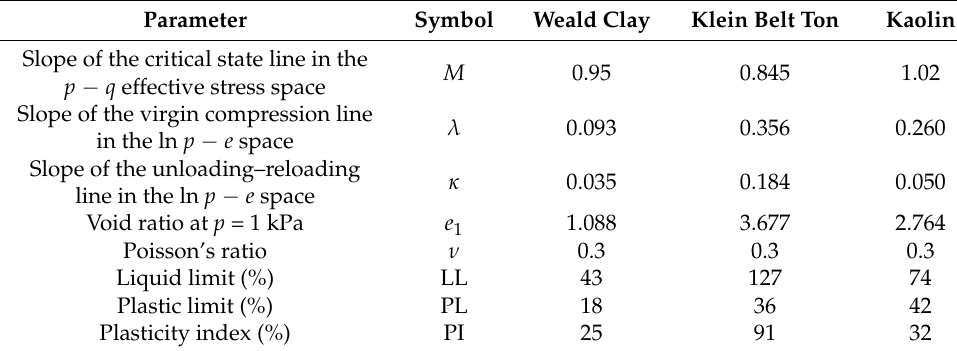
Figure 4. Strain paths ε α as a function of the angle α considered to define the number of N subdivi- sions of the yield surface. Table 2. Parameters used to characterise the behaviour of the clays assumed in the models (adapted from Schofield and Wroth [15]).